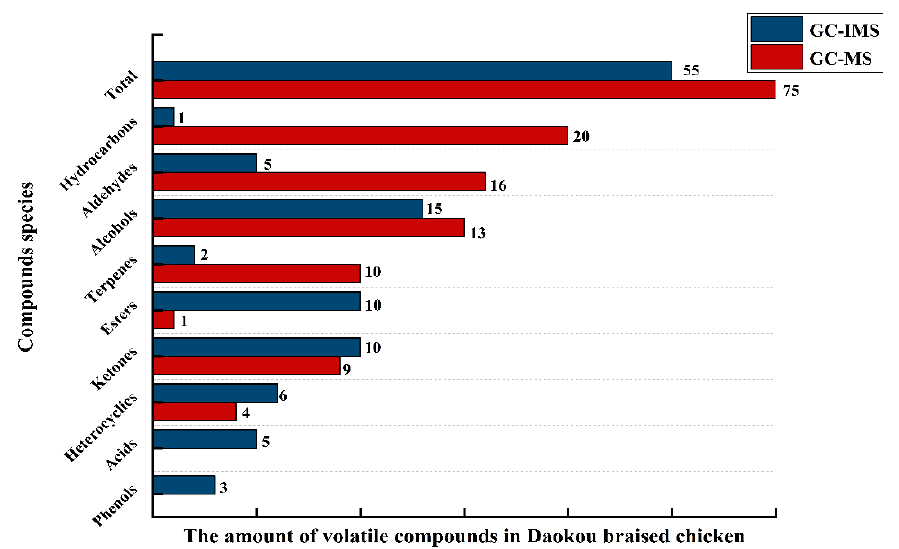
Figure 6. Comparison of the number of volatile flavor compounds detected by GC-MS and